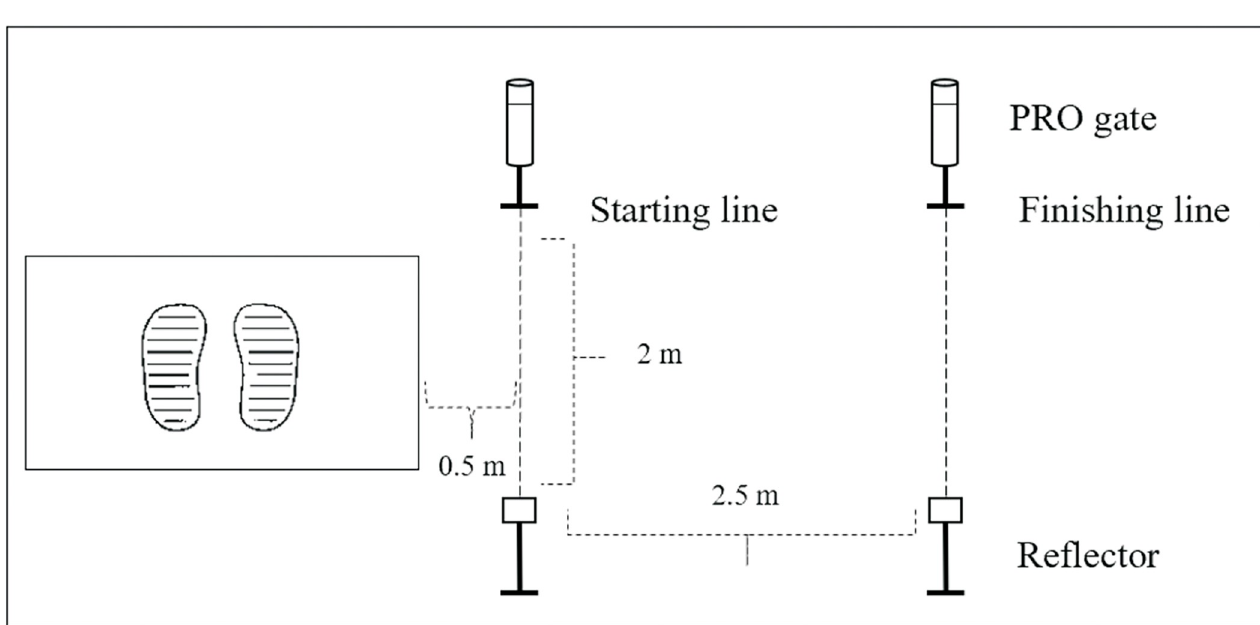
Fig 4. The 2.5 m LAT